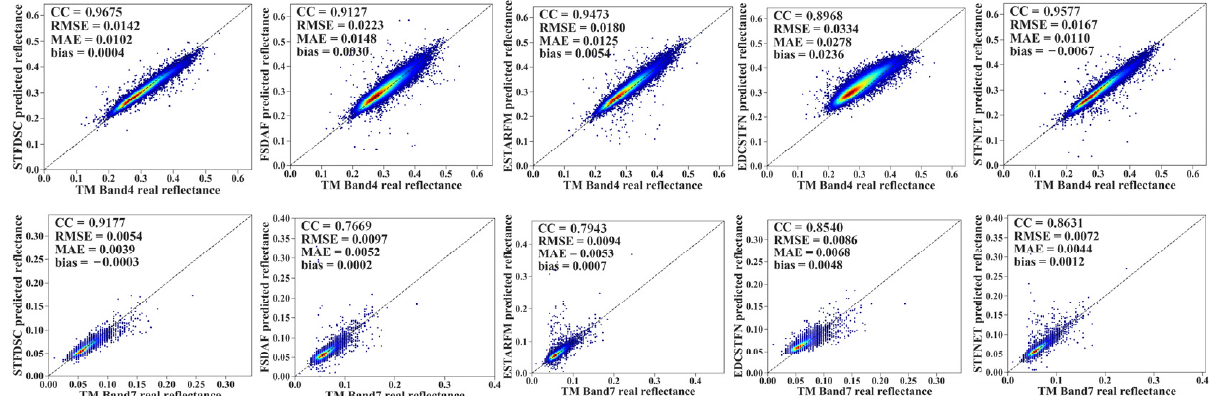
Figure 7. Scatter density plot of the observed reflectance and predicted reflectance at TM band 4 and band 7 in the GKM.